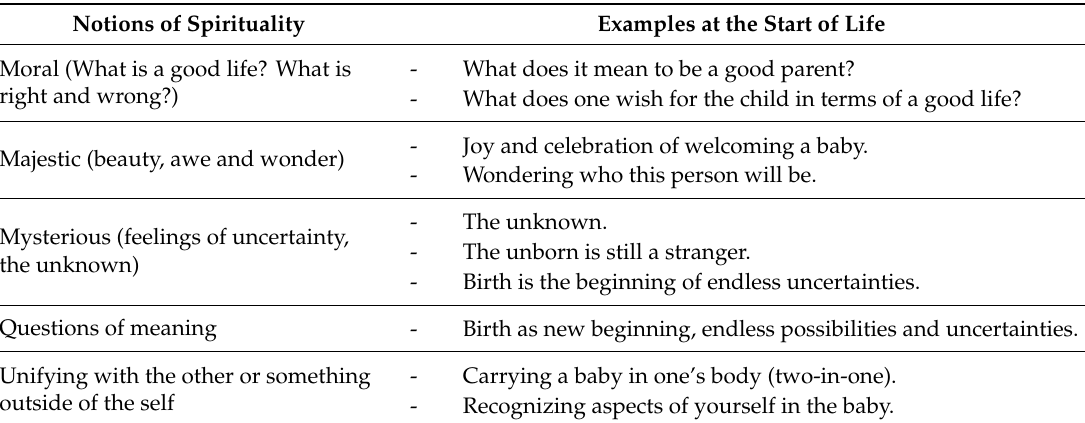
Table 1. Spirituality at the start of